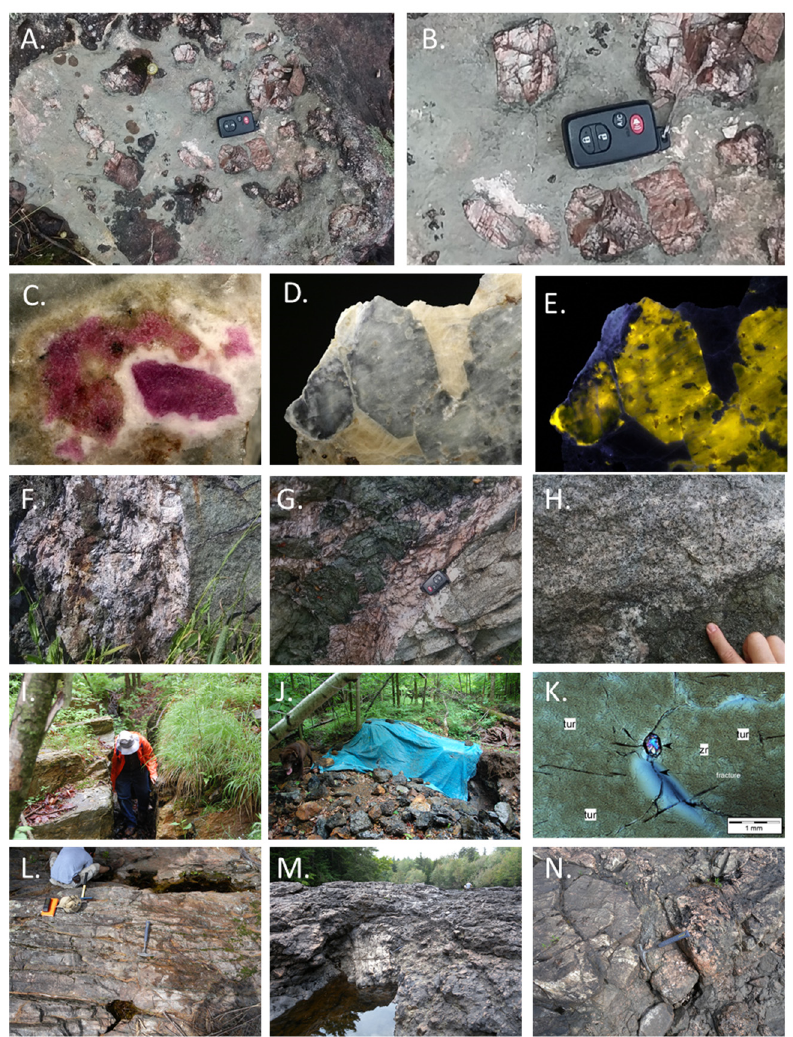
Figure 3. Photographs of select sampling sites. ( A ) Perthitic microcline crystals in calcite matrix, Fine locality. Key fob was 5 cm long. ( B ) Closeup of ( A ) showing euhedral, perthitic microcline crystals showing cleavage surfaces. ( C ) Corundum from the purple diopside mound, Rose Road locality (field of view 2 cm). ( D ) Scapolite crystals in calcite matrix, Rose Road locality (field of view 10 cm). ( E ) Same shot as in 3D viewed in long wave ultraviolet light displaying lemon yellow fluorescence of scapolite and dark blue fluorescence in calcite. ( F ) Contact between pink calcite pod and granular diopsidite, Edwards locality. The iron staining is from the oxidation of sulfide minerals, primarily chalcopyrite. The horizontal width of calcite pod was 1.5 m. ( G ) Pink calcite vein with large, euhedral diopside crystals (left) and granular diopsidite (right) from Edwards. Key fob for scale. ( H ) Diopside-rich marble xenolith in Edwards outcrop. ( I ) One of five parallel, north-trending trenches at Powers Farm. Coauthor George Robinson for scale. ( J ) Tarp (blue) covered trench (length = 2.44 m) at Powers Farm at one of the numerous dig sites. Note the tourmaline-rich debris (black) in the foreground to the right of Crunch, the chocolate lab. ( K ) Photomicrograph showing 500 µ m long zircon crystal in tourmaline from Powers Farm, cross polarizers (tur—tourmaline; zr—zircon). ( L ) Closely spaced brittle fractures cutting early foliation at Stone Valley. Fractures accentuatedj by calcite dissolution. ( M ) Large, meter-scale mylonitic block in tectonic breccia at Stone Valley in the bed of the Raquette River. Ben Valentino for scale (upper right). ( N ) Pink pegmatitic pod between mylonitic breccia fragments, Stone Valley. Hammer for